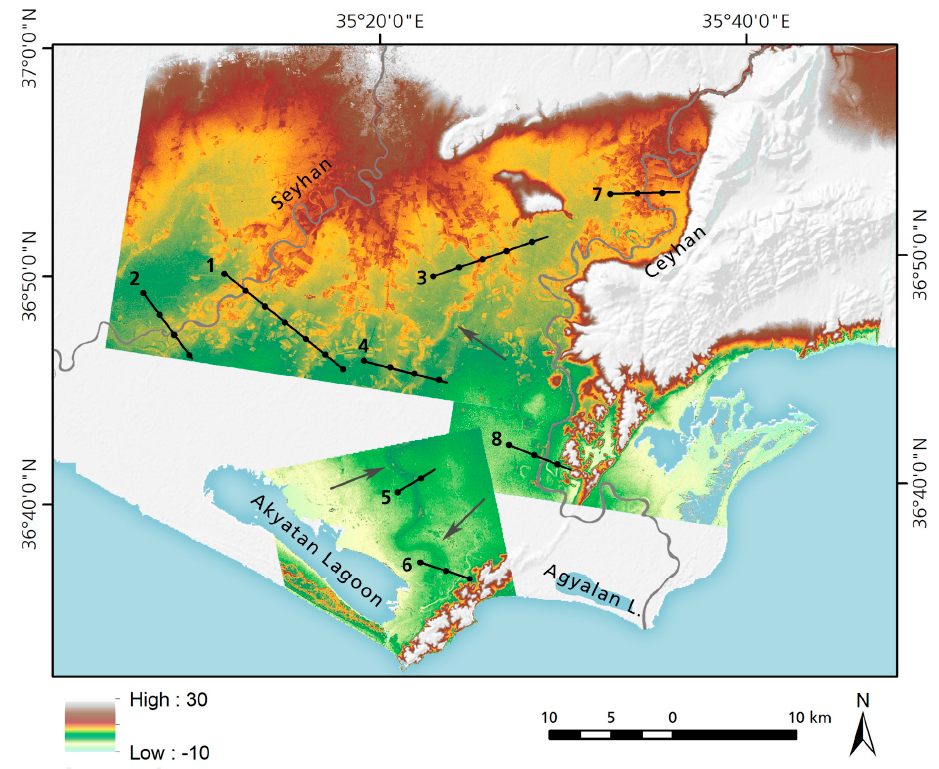
Figure 9. High-resolution digital elevation model based on TanDEM-X data (Stripmap) of the Çukurova. The grey arrows point to a large palaeochannel. The location of the cross sections is represented by black lines. The dots mark a distance of 2000 m © Susanne Rutishauser.